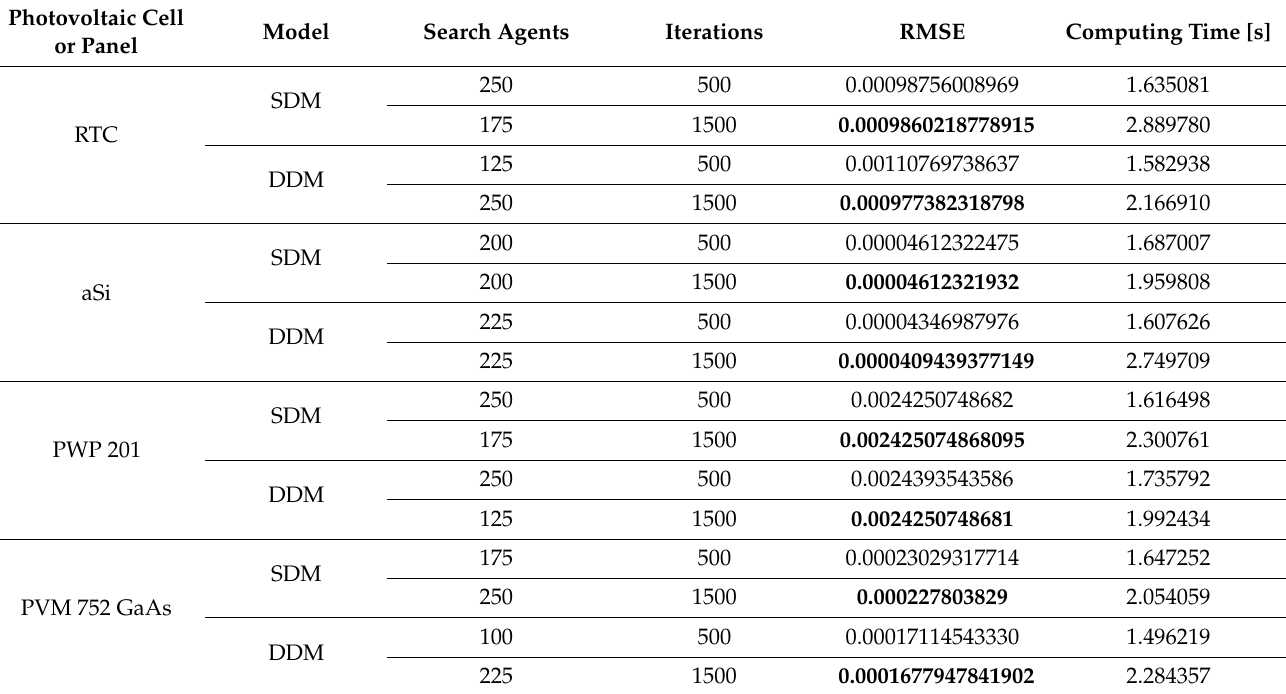
Table 11. The RMSE and computing time function of the iterations and population number. Photovoltaic